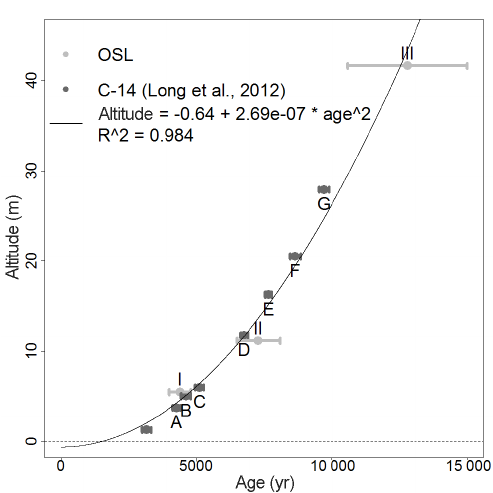
Figure 3. Elevation and age of OSL dates (this study) and radiocar- bon dates (Long et al., 2012). Ages are displayed with a confidence interval of 2 σ . The black line shows the quadratic regression be- tween altitude and age of each dating. The symbols A–G and I–III refer to the respective locations in Fig.